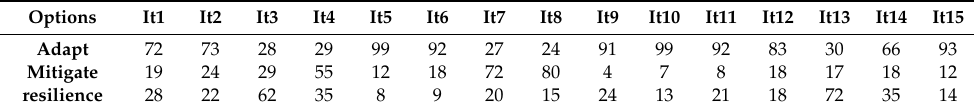
Table 4. Responses of CC actors in Niger.